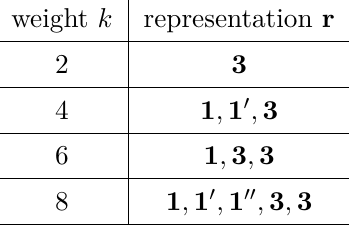
Table 1 . The transformation properties of the weight k and the level 3 modular forms Y ( k ) r under A 4